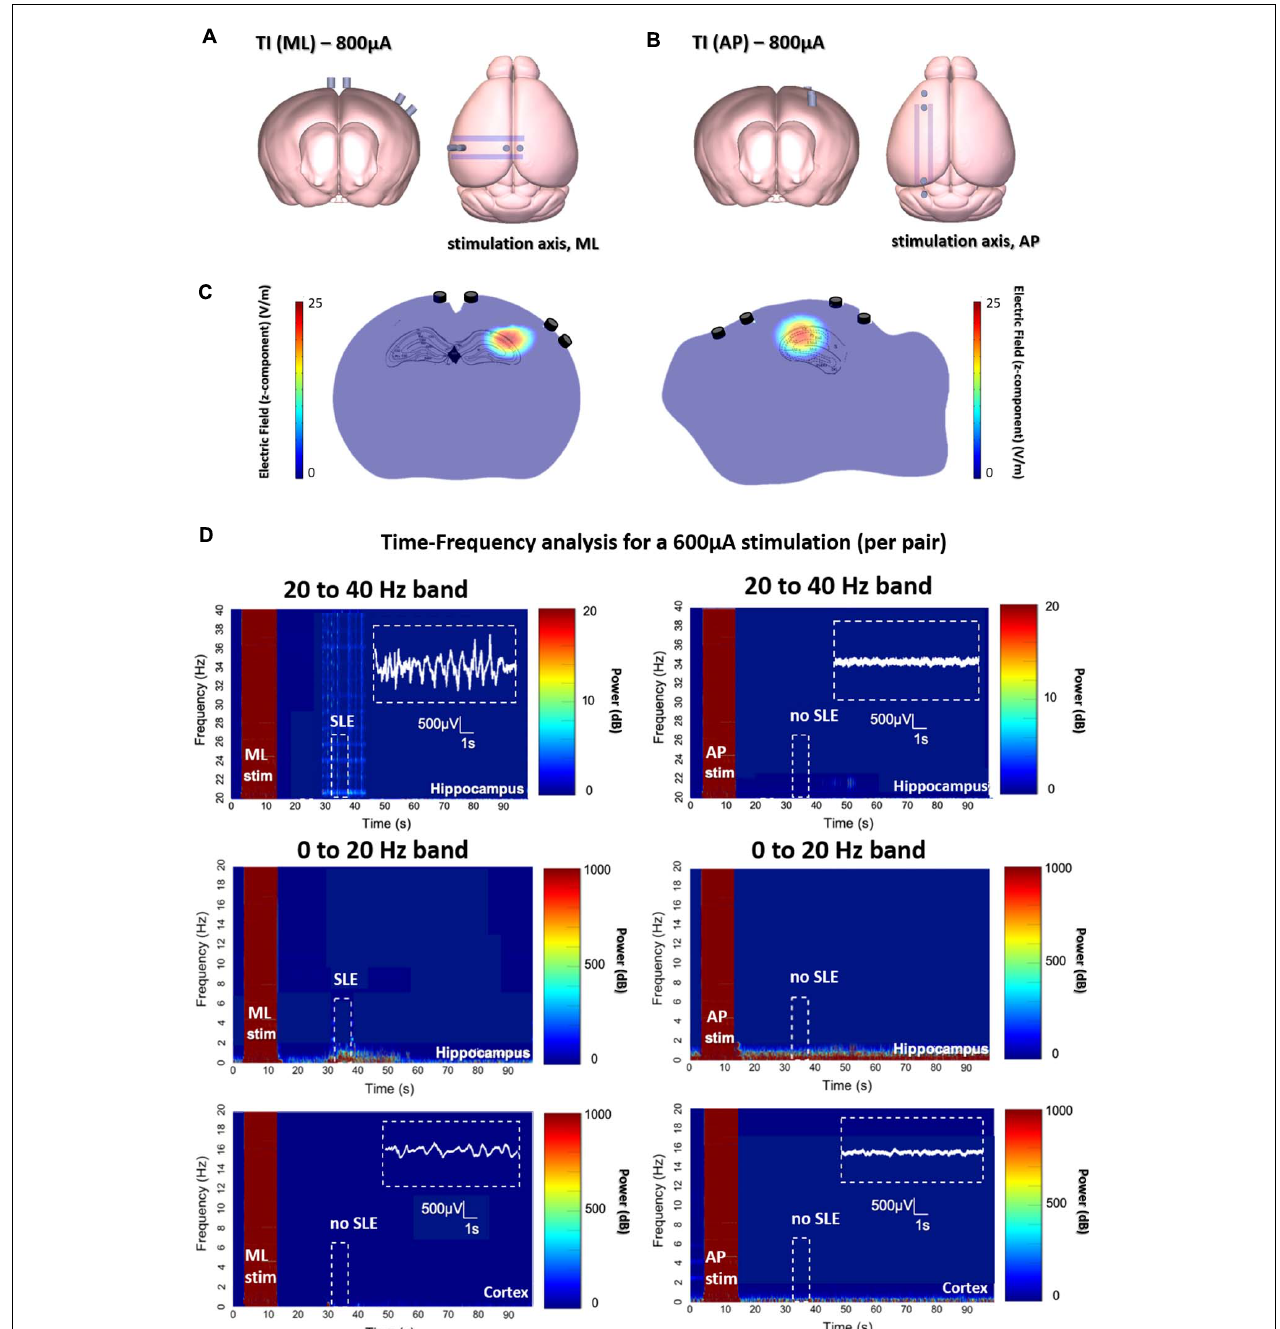
FIGURE 2 | Evoked SLEs in the hippocampus of freely moving mice. (A,B) Depict the two ot-TI stimulation axes with electrodes to-scale. (C) Using Finite-element method simulation, the associated hotspots (maximum envelopes of electric field) are seen in the hippocampus, with the maximum amplitude placed at the CA3-CA1 junction as planned in the protocol. For ML/AP orientations, the electric field lines are parallel/perpendicular to the Schaffer collaterals. (D) Real biologically evoked SLEs in mice using ot-TI. For the ML orientation (left panels), parallel to the axons of the hippocampus, the shape of the evoked activity, the associated increase in frequencies of the beta/gamma range (20–40 Hz), and observed behavioral seizures demonstrate a classic SLE, however, it is the first minimally invasive evoked SLE by using TI. The AP orientation (right panels), perpendicular to the axons of the hippocampus, showed no evoked SLEs, and for 8 mice only one showed a stage 4 behavioral seizure on the Racine scale with a threshold above 900 µ A. Placement of recording electrodes in Supplementary Figure 6 . Time-Frequency plots and evoked SLEs are shown for 1 representative ML mouse and 1 representative AP mouse from n = 8 groups. Group statistics regarding events are shown in subsequent